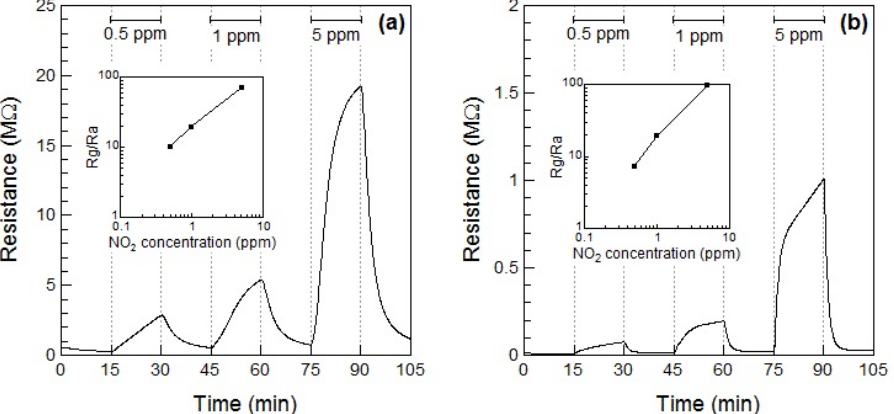
Figure 2. Response of the sensor element using WO (0, 0.5, 1, and 5 ppm) in air at ( a ) 100 °C and ( b ) 200 °C. The inset shows the relationship between the sensor response and NO